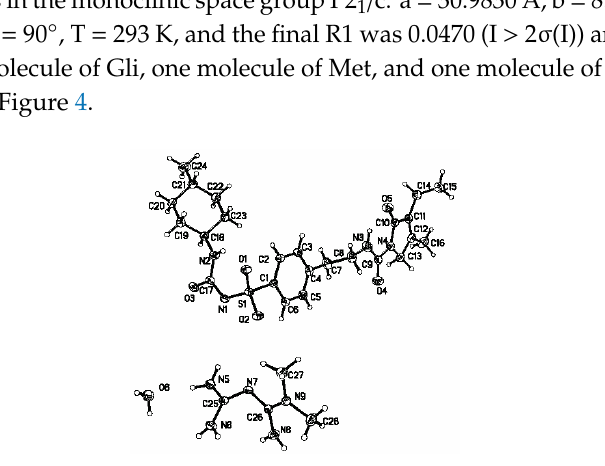
Figure 4. Thermal ellipsoid figure for the Met ion, Gli ion, and H 2 O molecules drawn at 50% probability level.